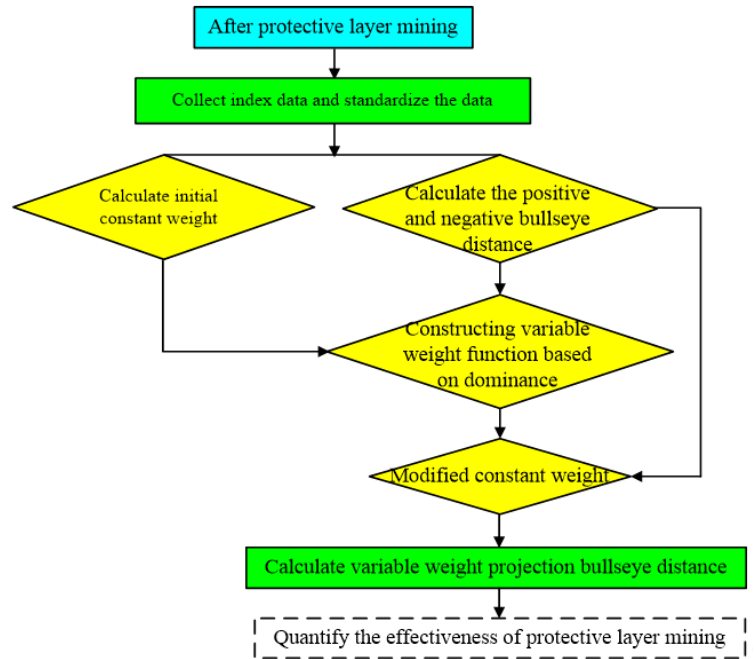
Figure 1. Calculation